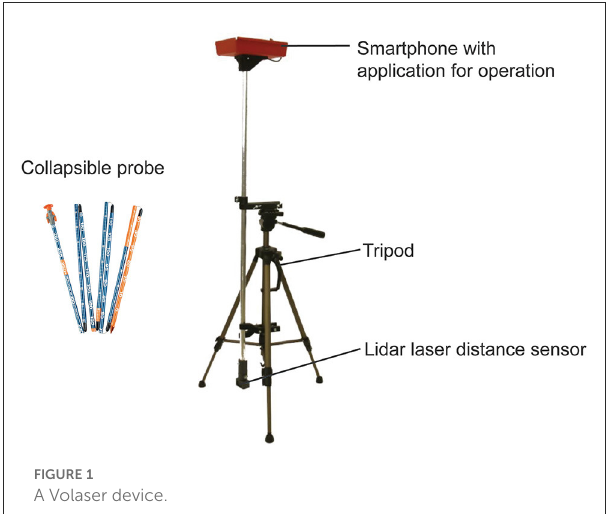
FIGURE1 A Volaser device.